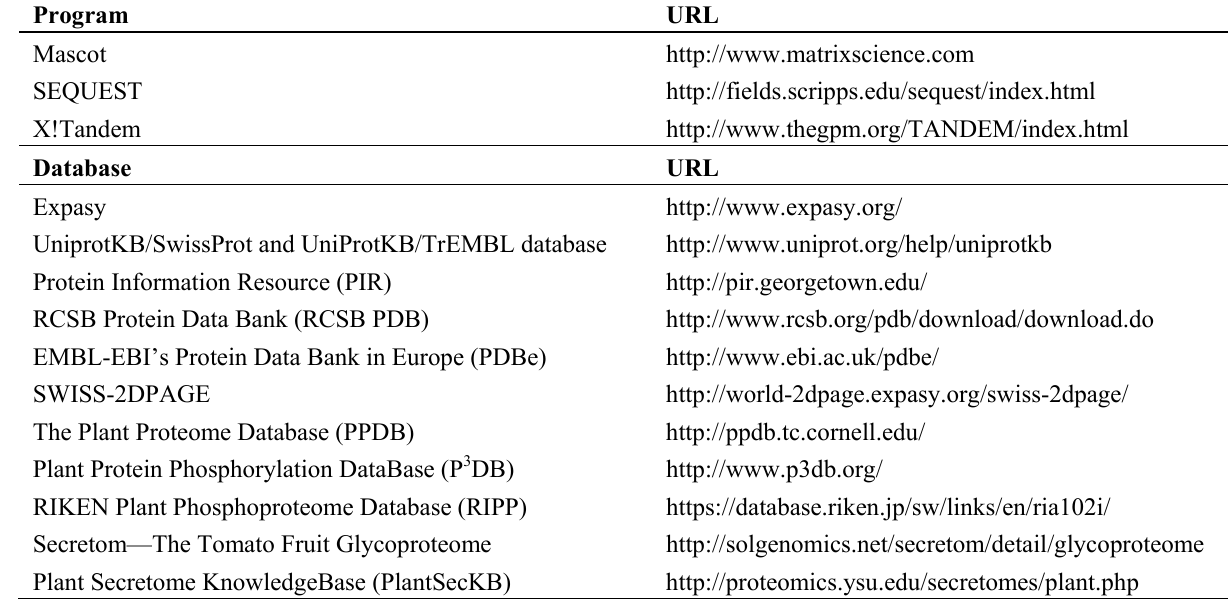
Table 5. Bioinformatics resources commonly used in crop proteomic